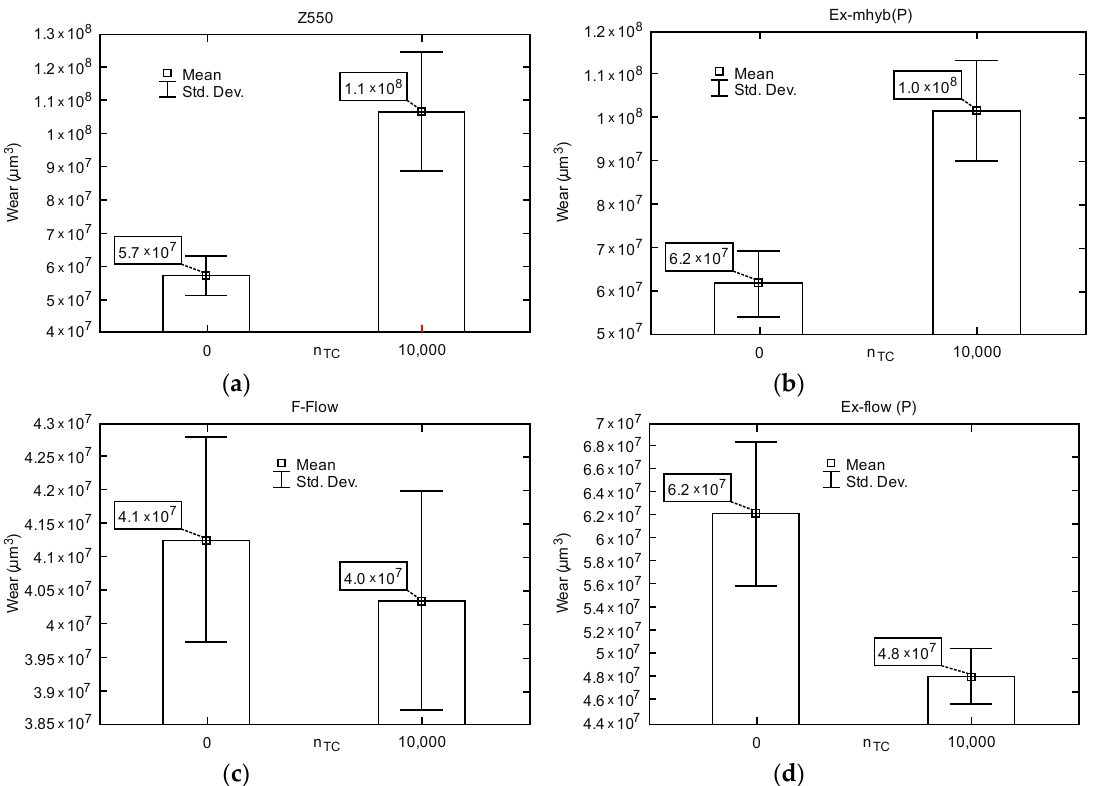
Figure 4. Typical 2D profile of dental material wear mark.